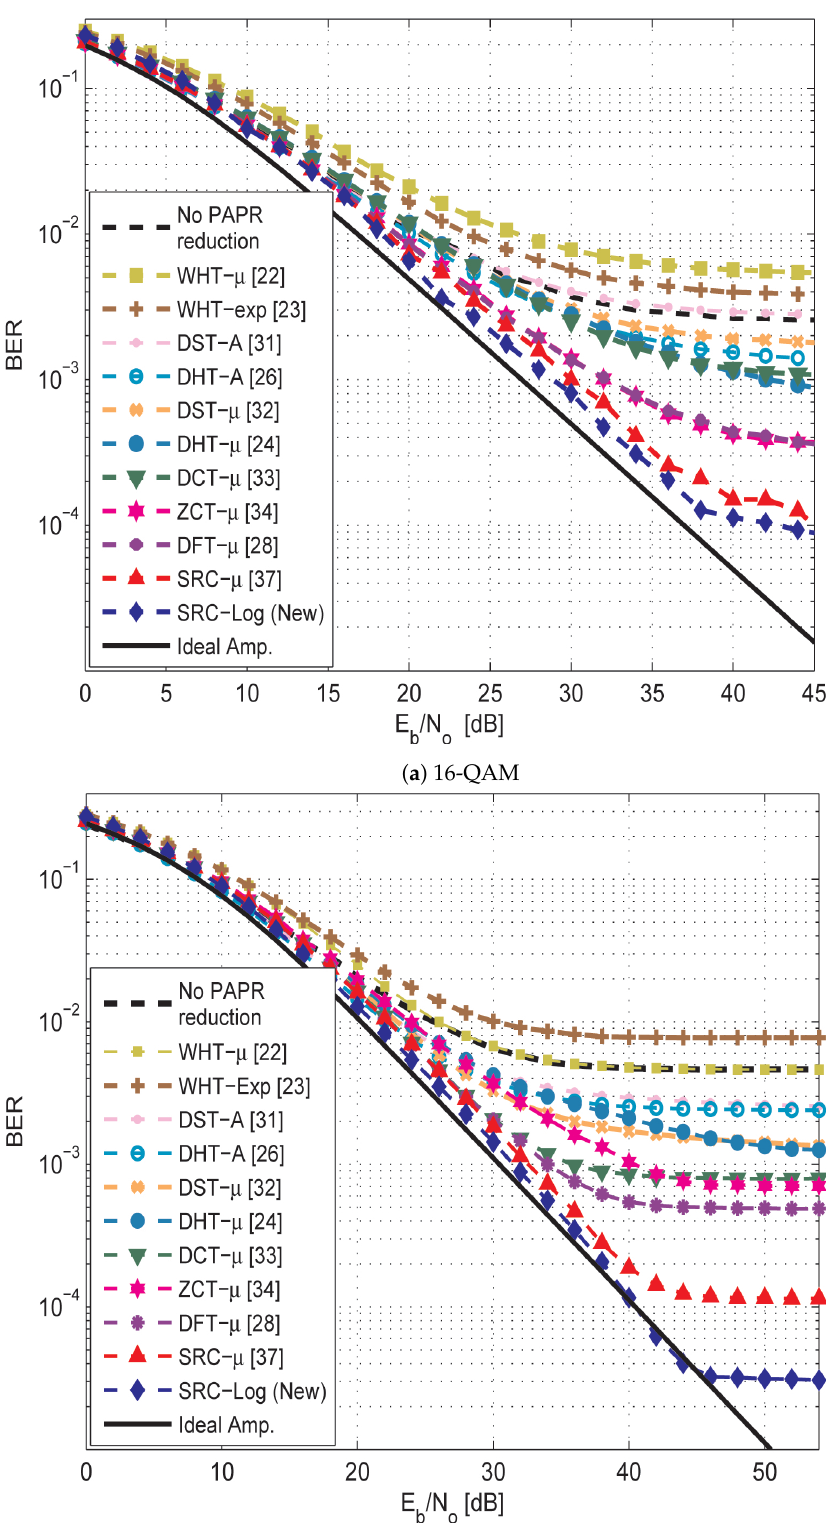
Figure 9. BER performance of the new SRC-Log compared with the previous precoding-companding techniques and OFDM without PAPR reduction in Rayleigh channel. In addition to the case of an ideal amplifier (solid